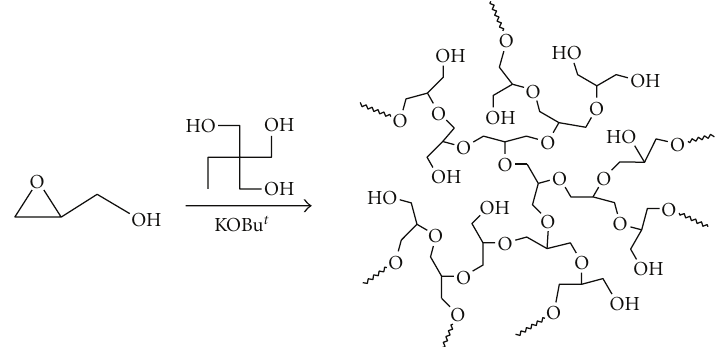
Scheme 6: Synthesis of hyperbranched polyglycerol from